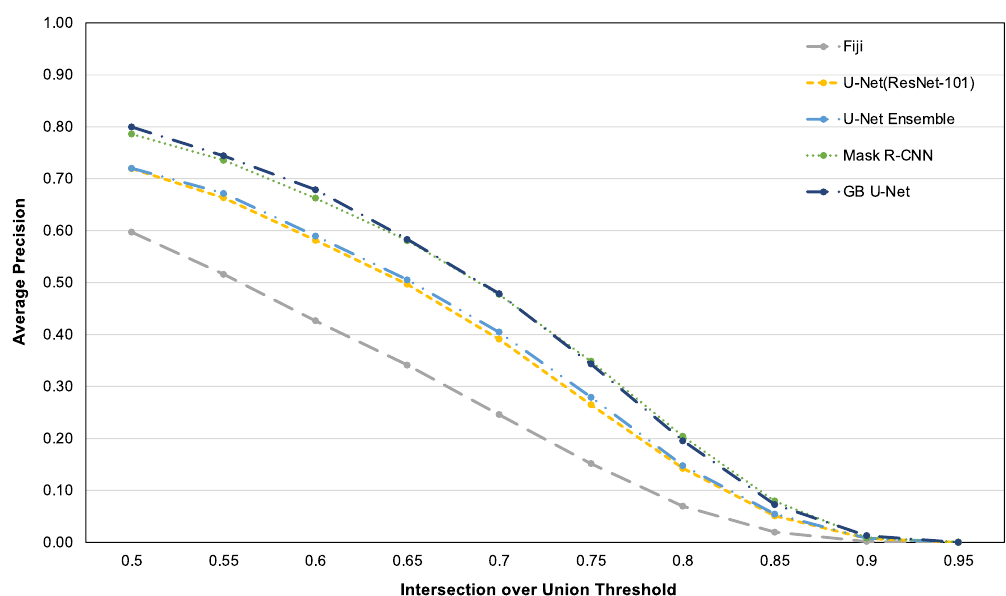
Figure 2. Average precision graphically displayed, across ten intersection over union thresholds, for the MoNuSeg test